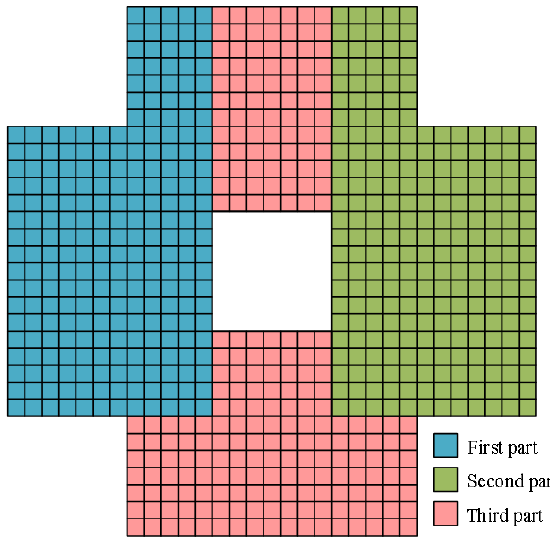
Figure 17. Regional division for time-sharing calculation.